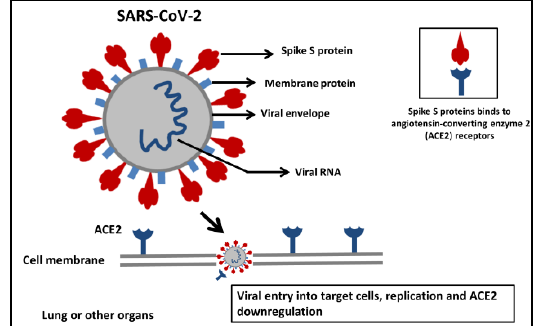
Figure 2. Viral entry mechanism of SARS-CoV-2 into the host